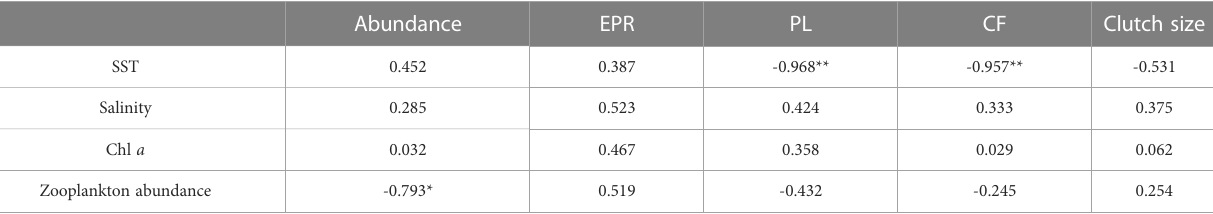
TABLE 1 Spearman correlation coef fi cients between ecological indicators of O. similis and environmental factors.